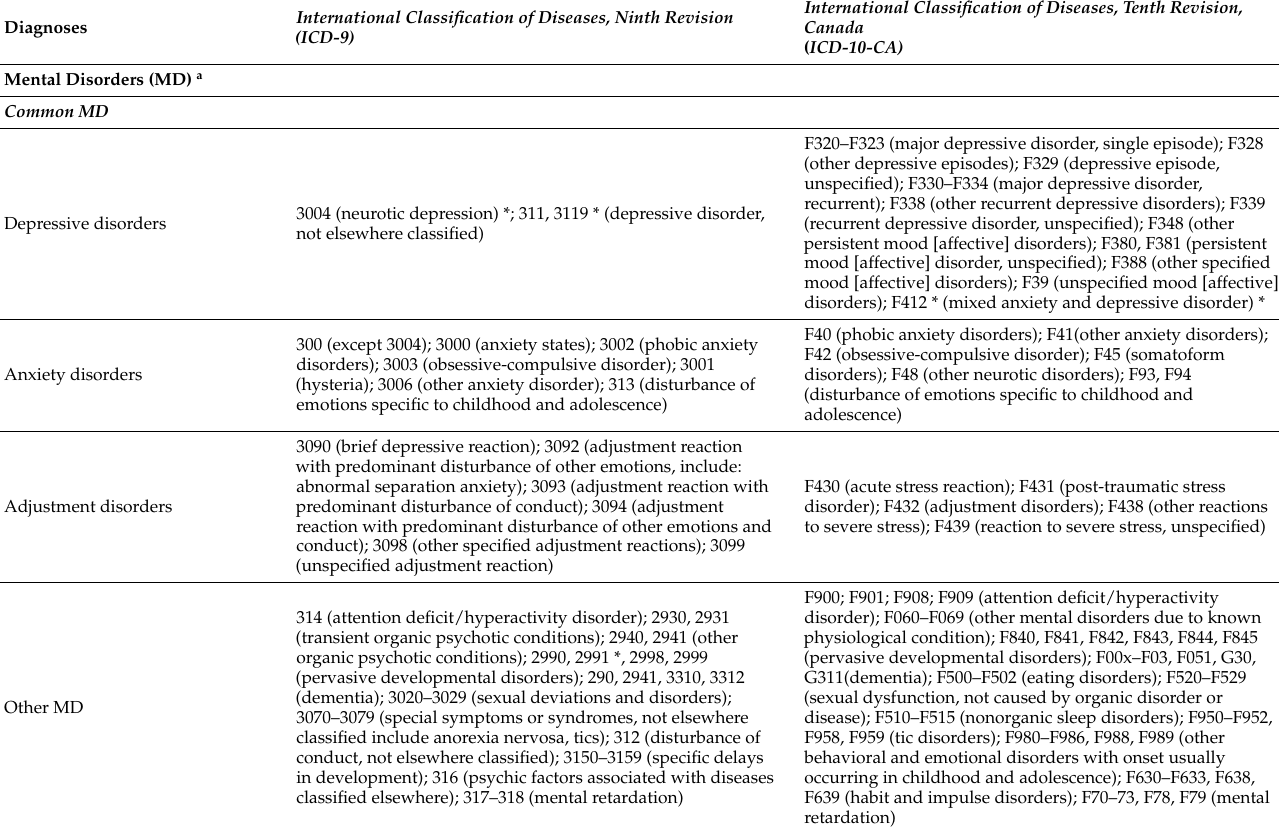
Table A1. Codes for Mental Disorders, including Substance-Related Disorders and Chronic Physical Illnesses, according to the International Classification of Diseases, Ninth and Tenth